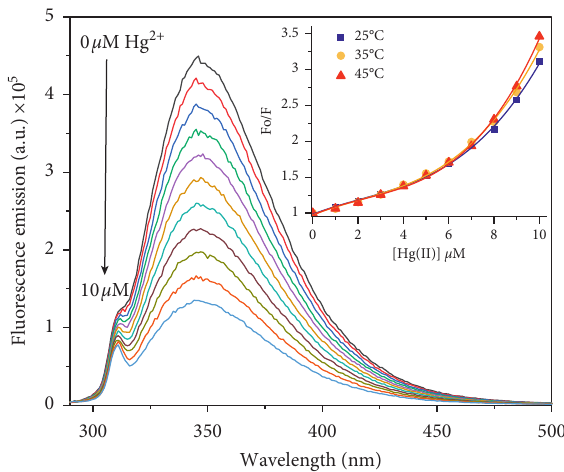
Figure 5: Fluorescence spectra of 10 µ M WCGC following titration with increasing concentrations of mercury(II) at 35 ° C. Inset: Stern- Volmer plots at 25 ° C, 35 ° C, and 45 °